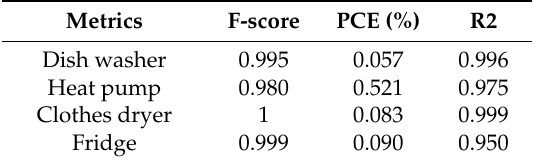
Table 2. The disaggregation accuracy metrics for the proposed method.